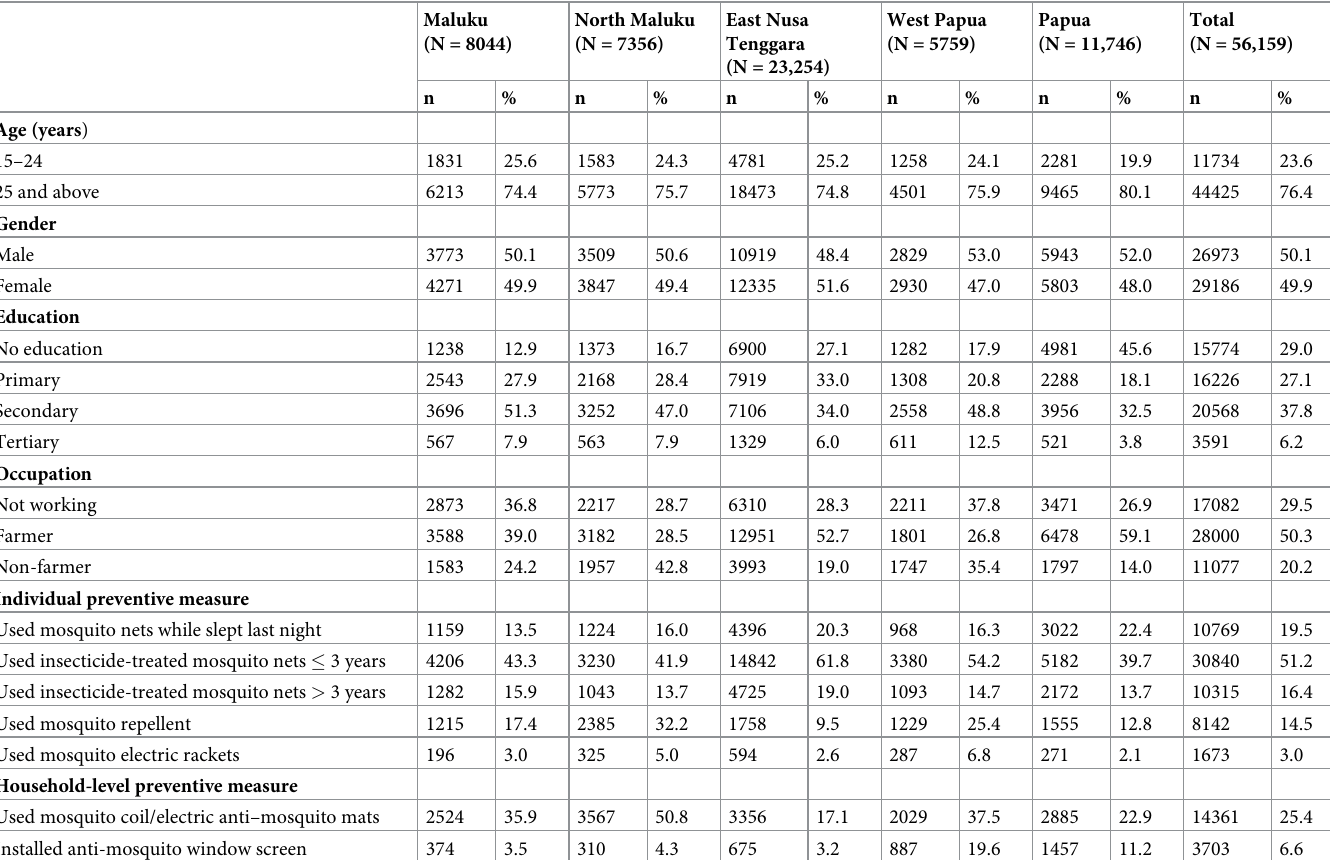
Table 1. General characteristics of the respondent who included in the analysis, in the five selected provinces in eastern